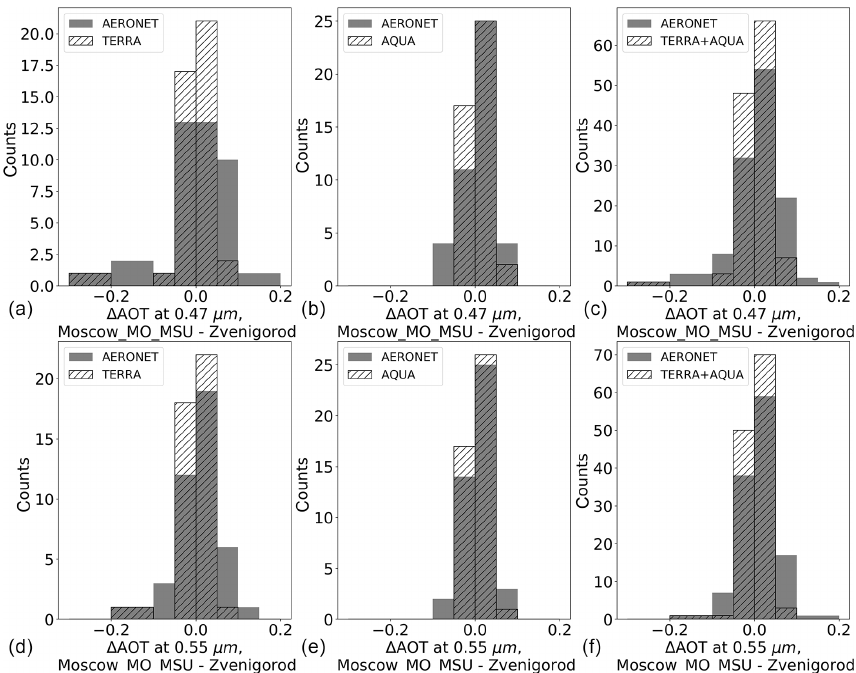
Figure 6. Frequency distribution of (cid:49) AOT ( (cid:49) AOT = AOT Moscow_MO_MSU − AOT Zvenigorod ) at 0.47µm (a, b, c) and 0.55µm (d, e, f) separately for the Terra (a, d) and Aqua (b, e) datasets and together for the data from the two satellites (c, f) with frequency distribution for matching ground-based AERONET data (2006–2017, without the data of 2009 because of technical problems at the Zvenigorod AERONET site). The number of satellite and ground-based matchups is